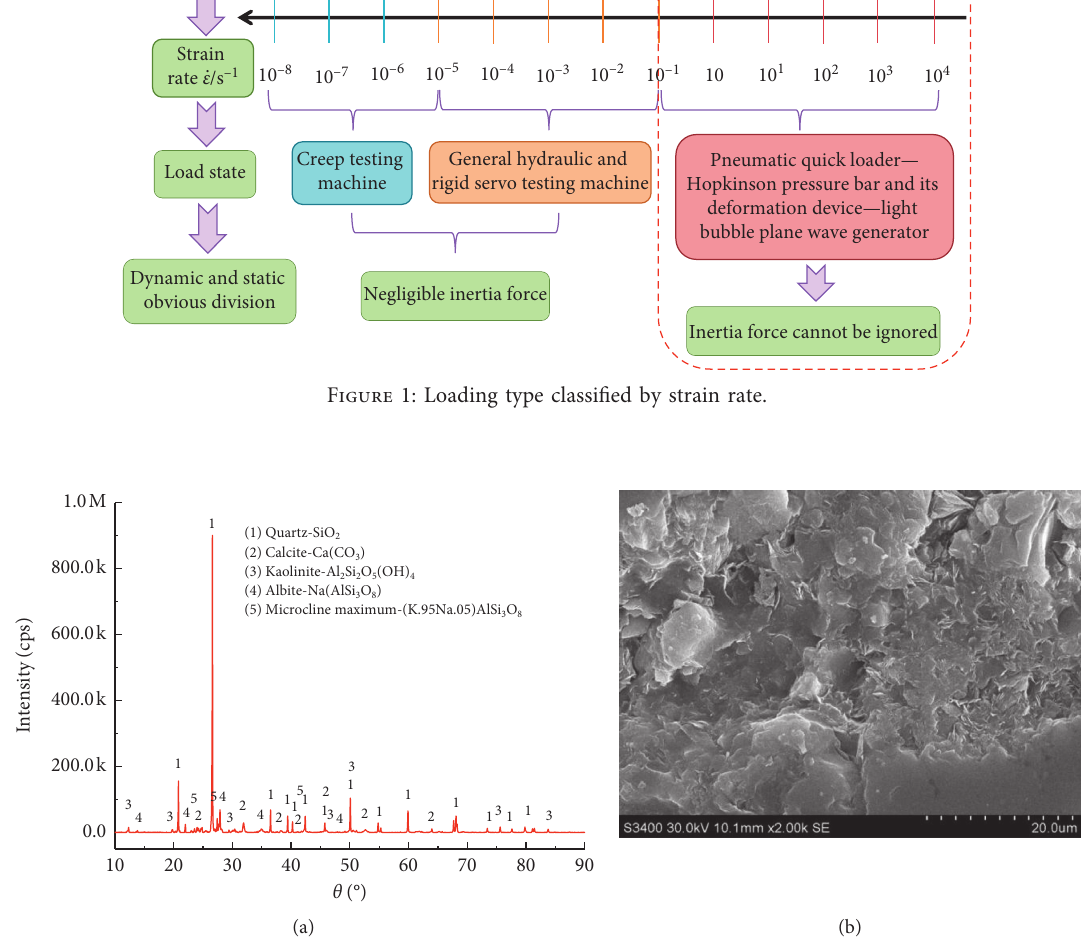
Sample preparation